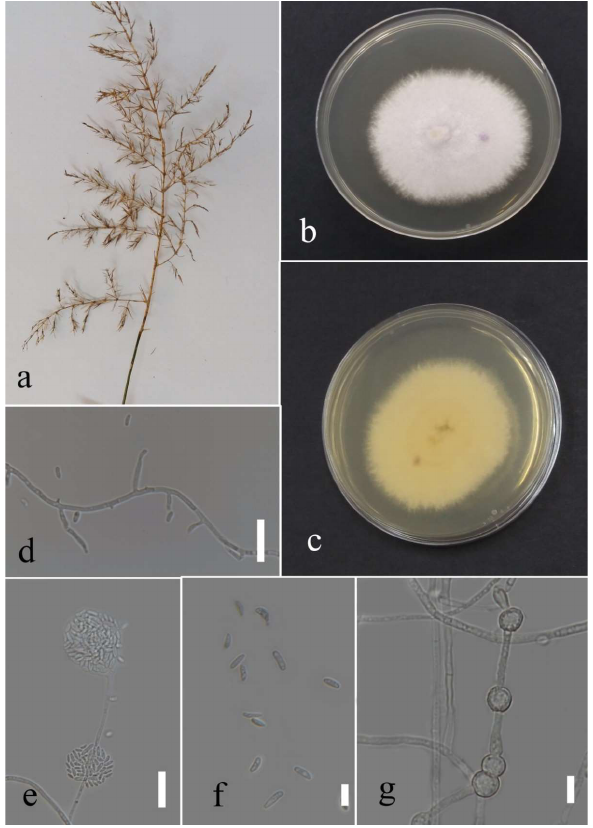
Figure 38. Morphology of Fusarium nirenbergiae (MFLUCC 22 - 0155): ( a ) symptoms on Asparagus setaceous ; ( b , c ) upper and reverse views of the colony after seven days of growth on PDA at 28 °C; ( d ) phialides; ( e ) false head; ( f ) conidia; ( g ) chlamydospores. Scale bars ( d , e ) = 20 µ m and ( f , g ) = 10 µ